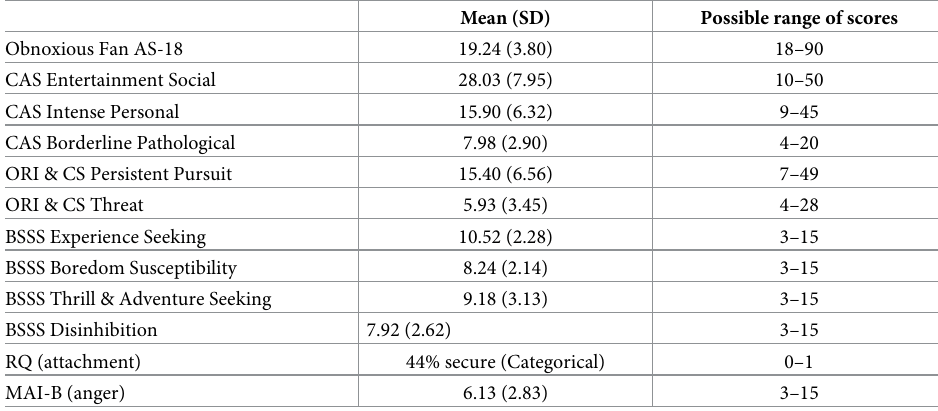
Table 1. Means, standard deviations, and possible range of scores for each measure.